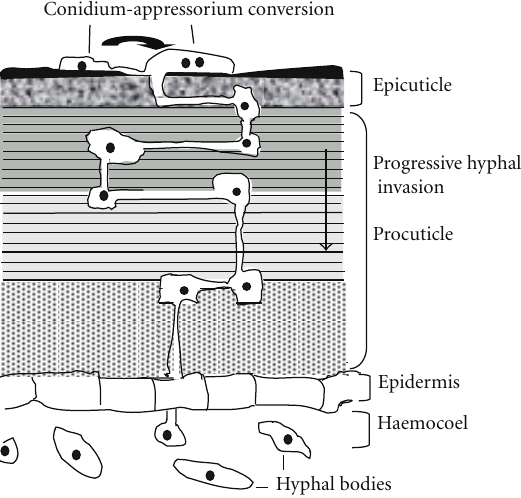
Figure 1: Depiction of the infection process in B. bassiana: struc- ture of the insect cuticle and mode of penetration of fungal hyphae. Formation of the appressorium from the conidia helps in cuticle invasion and subsequent hyphal penetration to the haemocoel. Tissue invasion by hyphae and proliferation of hyphal bodies leads to insect